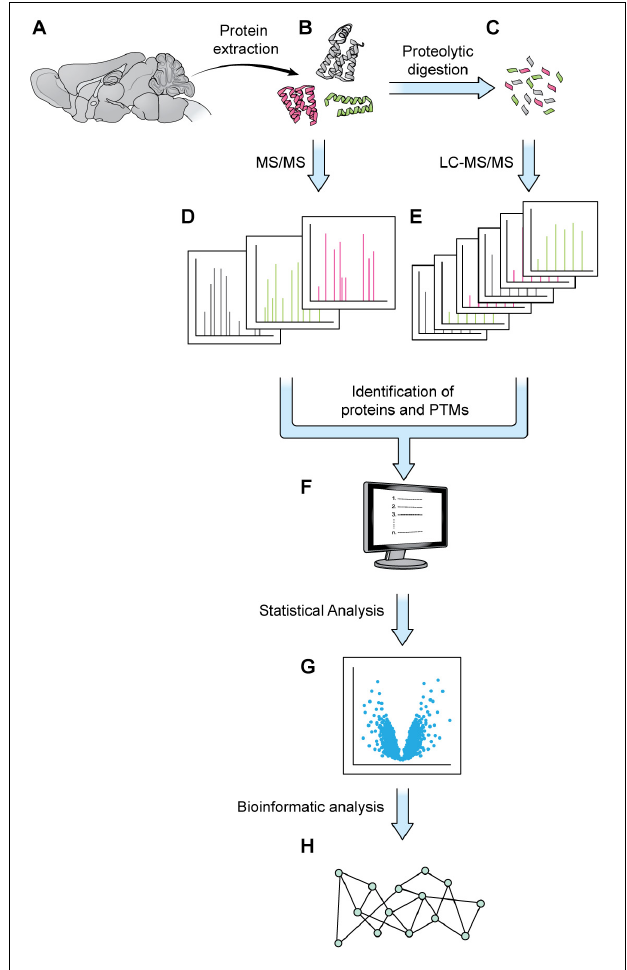
FIGURE 1 | Generic mass spectrometry-based proteomics workflow. Proteins are extracted from a biological sample. With the bottom-up approach, proteins are digested into shorter peptides, then used for LC-MS/MS data acquisition (steps A–C , E , without step D ). With the top-down approach, the intact protein is subjected to MS/MS analysis without digestion (steps A , B , D , no steps C,E ). MS1 and MS2 data are processed by a database search or a de novo sequencing algorithm to obtain protein sequence and PTM status (F) . The abundance of MS1 and/or MSn signal can be employed for protein quantitation and statistical analysis (G) . Various bioinformatics tools such as GO analysis or pathway analysis can be used to extract biologically relevant information from proteins of interest discovered in proteomics analysis (H)